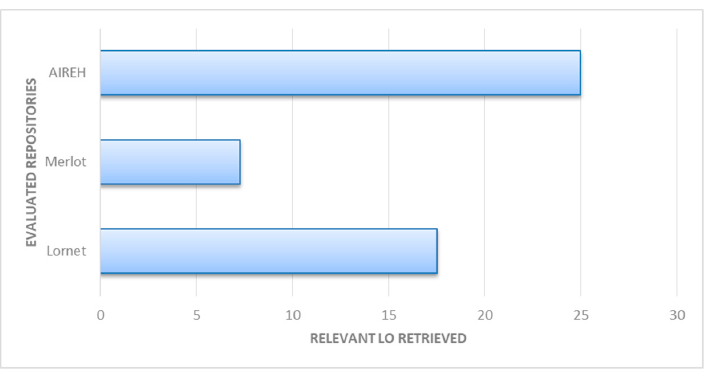
Figure 7. Average metadata documents retrieved during the testing phase.